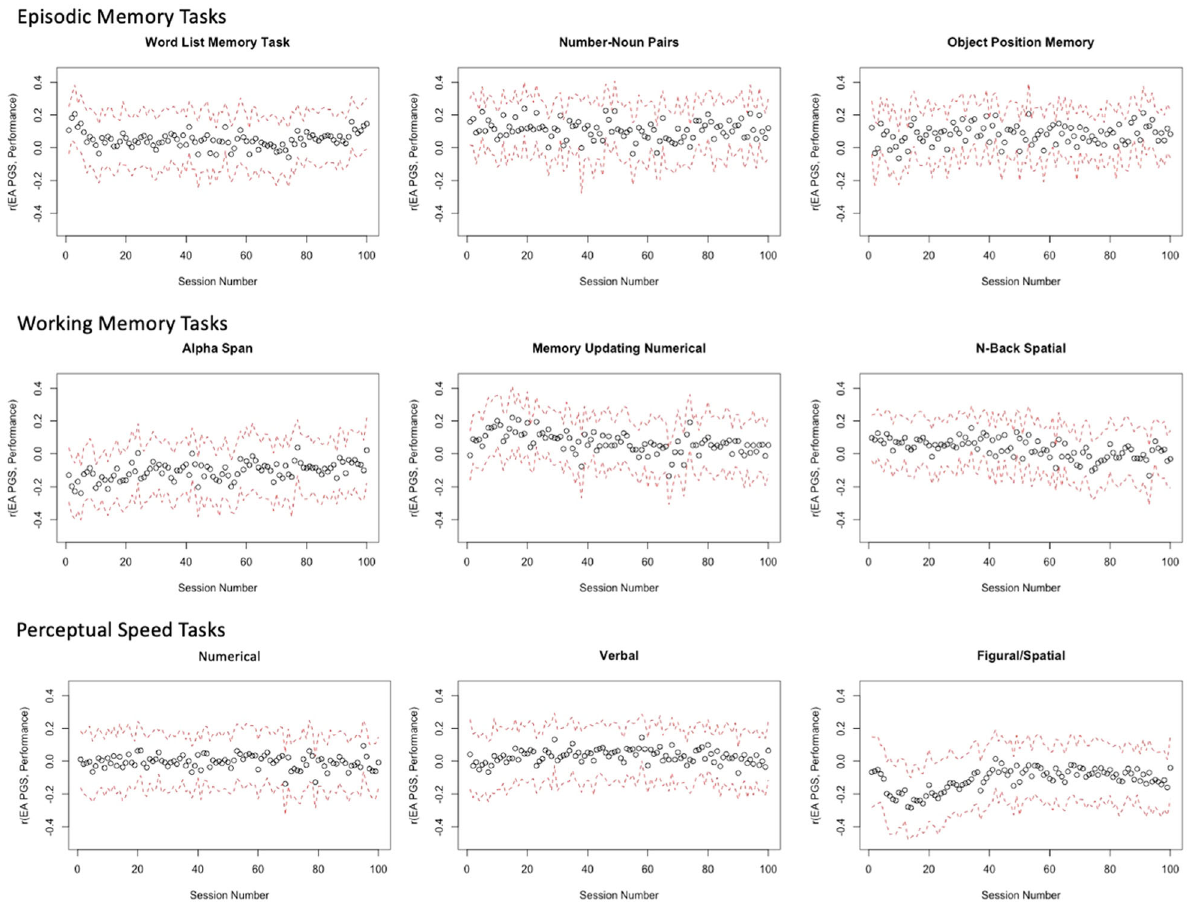
Fig. 3 Paneled plot of correlations between EAPGS and performance on all cognitive tasks over the practice phase. The black circles indicate correlations between EAPGS and performance, and the red dotted lines indicate 95% con fi dence intervals.